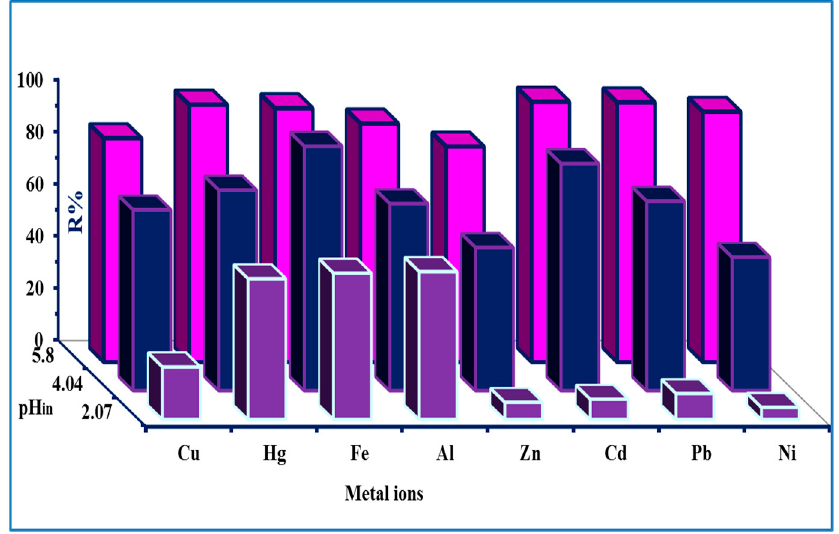
Figure 6. Comparative studies of the removal efficiencies after treatment of water samples (pH in , 2.07, 4.04 and 5.8; SD: 1 g L − 1 ; T: 23 (±3) °C; time: 5 h; agitation speed: 170 (±3) rpm) at different pH 2.07, 4.04 and 5.8; SD: 1 g L − 1 ; T: 23 ( ± 3) ◦ C; time: 5 h; agitation speed: 170 ( ± 3) rpm) at different values. pH